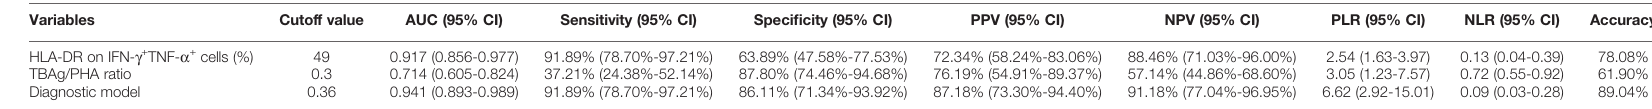
TABLE 3 | The performance of various indicators for discriminating ATB from LTBI in Caidian cohort.